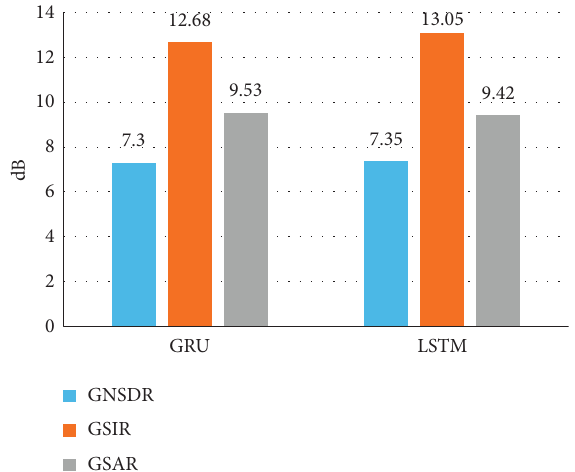
Figure 4: The comparison for the effect of GRU and LSTM in ASSM.